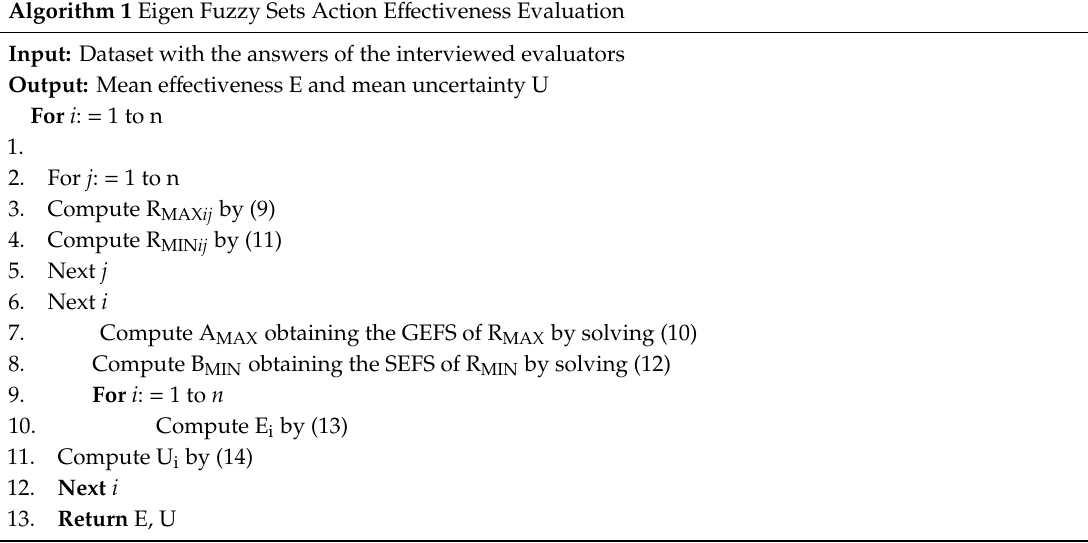
Algorithm 1 Eigen Fuzzy Sets Action E ff ectiveness